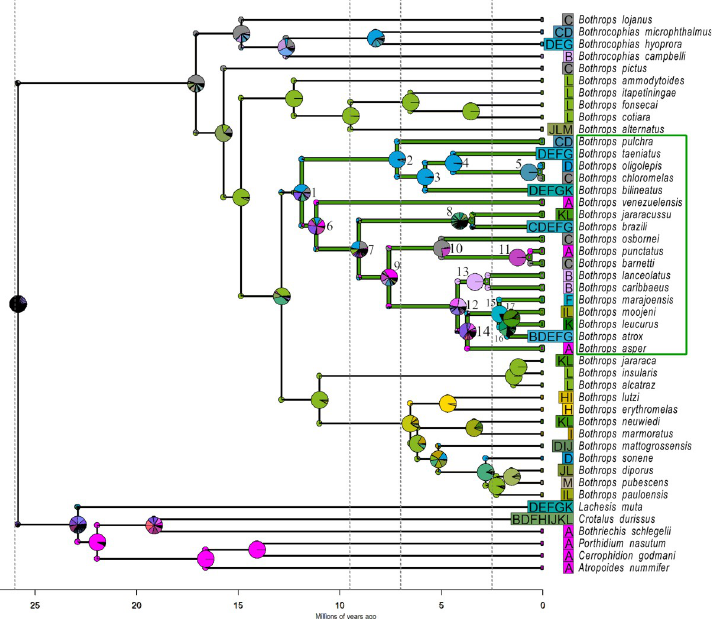
Fig 4. Ancestral geographic range probabilities associated with the range reconstruction of Bothrops forest clade under the DIVALIKETS model. Pie charts in nodes represent the geographic range probabilities of each hypothetical ancestor. Pie charts in the corners of the cladogram represent the geographical range probabilities inherited from the hypothetical ancestor immediately after a cladogenetic process. Colors represent biogeographical units. Units next to species names represent the current geographic distribution of each species. The green clade highlights the focal forest clade. Vertical dashed grey lines mark the time slices defined in the time stratified matrix. Focal nodes discussed in the text are